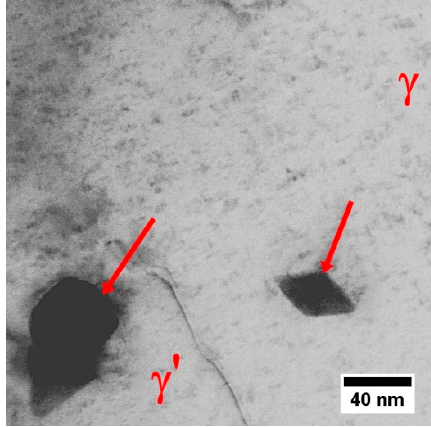
Figure 11. Nano-precipitates in dendritic regions, STEM-BF.